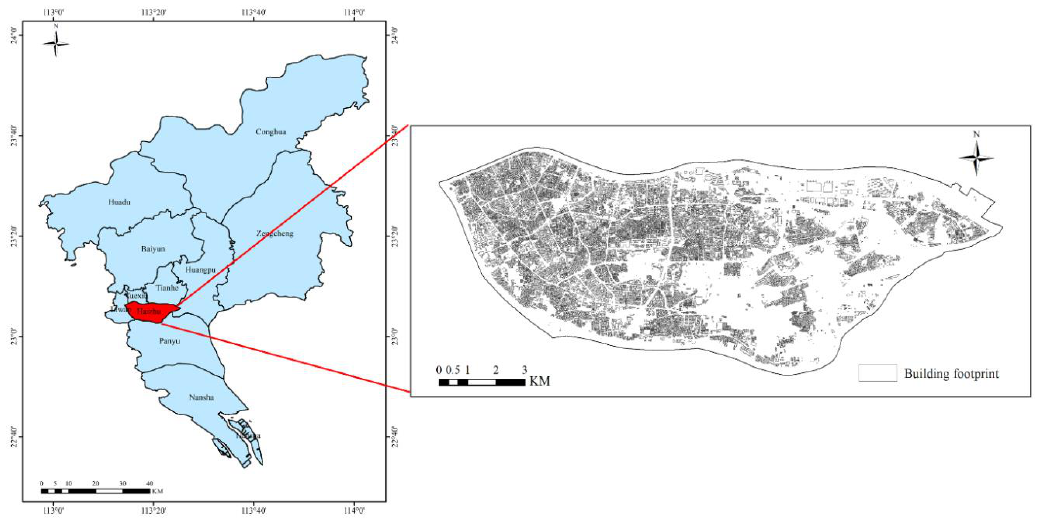
Figure 1. Location of the Haizhu case study area and its building footprints.